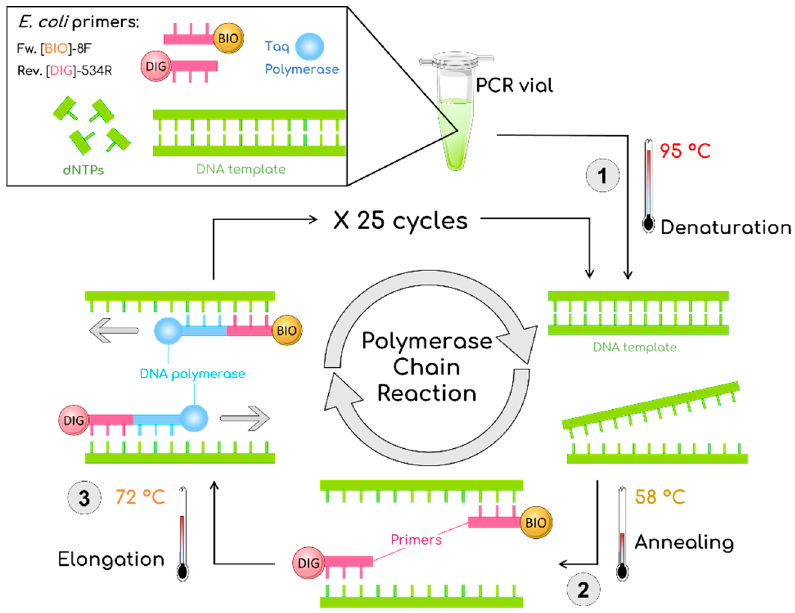
Figure 1. Schematic description of the double ‐ tagging PCR for the amplification of the Escherichia coli 16S ribosomal gene, including an initial step at 95 °C for 3 min followed by 25 cycles of 95 °C for 30 s, 58 °C for 30 s, 72 °C for 30 s, and a final step of 7 min at 72 °C. BIO is biotin marked with orange; DIG is digoxigenin marked with pink. Table 1. Sequences of the set of primers for the double ‐ tagging PCR amplification of E. coli . Strain and Gene